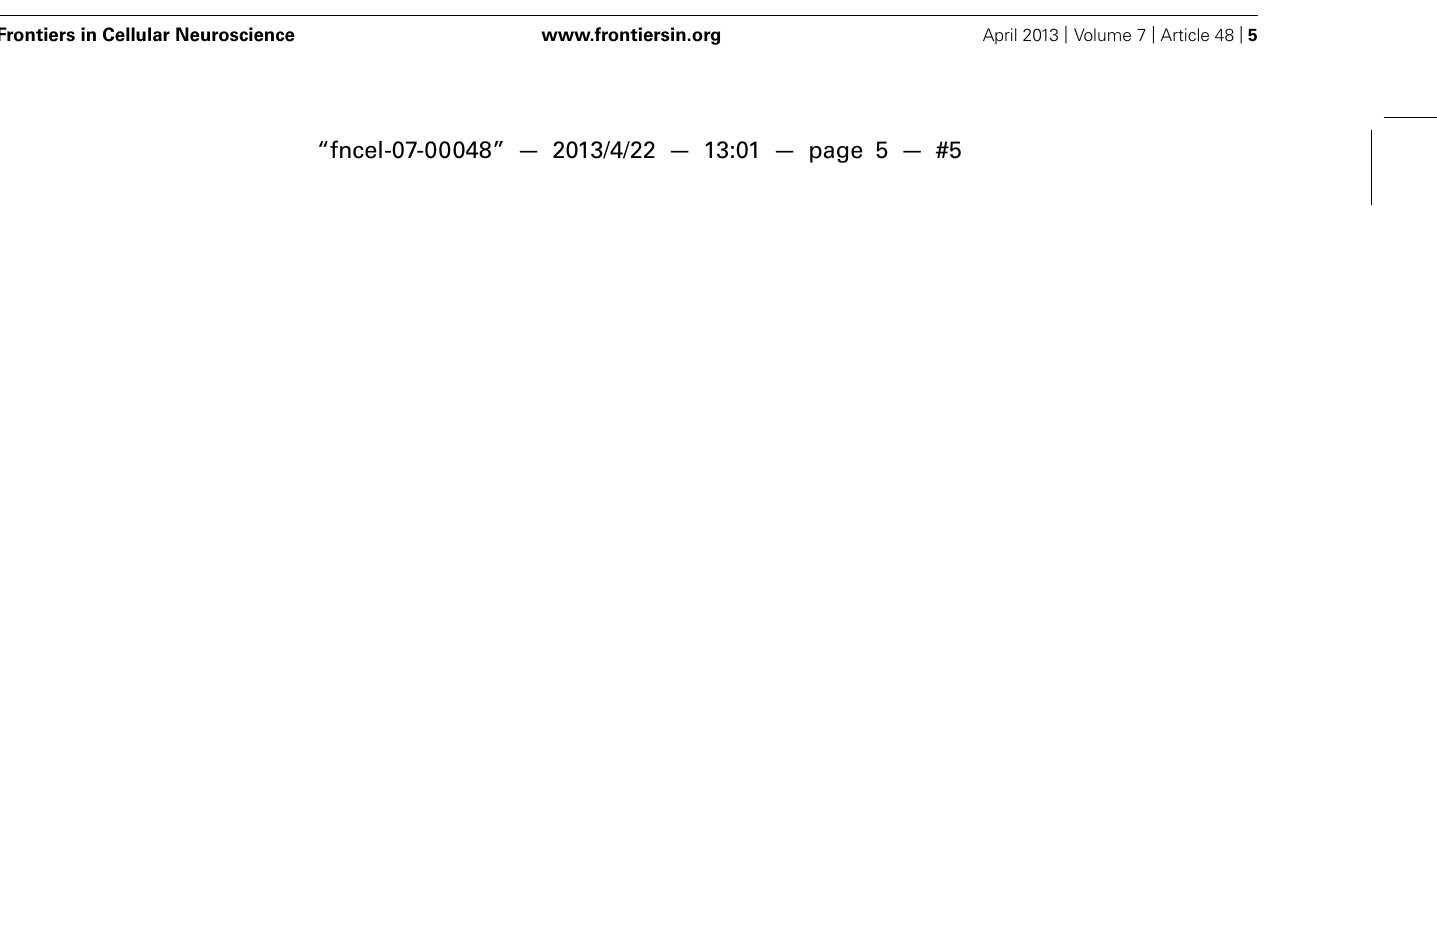
warm: − 44.9 ± 1.7 mV; AHP: cold: 15.0 ± 0.7 mV; warm: 16.6 ± 3.1 mV. P value for each data group > 0.05. N: cold-cut n = 5, warm-cut n = 5. R m , input resistance; AP, action potential; APHW, action potential half-width; I CMD , step command current; C m , estimated neuronal capacitance (see methods). For averaged AP shapes, the thickness of the trace signifies ± SEM. Note that for bar graphs in A (bottom right), values for APHW and I h -sag have been scaled (100 × and 10 × , respectively) for visual clarity. Also, note that in the left graph of the bottom panel, for correct comparison of current-to-firing relationships between neurons of possibly differing membrane resistances, the command current ( I CMD ) is scaled by multiplying by the measured R m for each cell. (B) . Morphology of a Purkinje neuron from a warm-cut slice (mouse age P18) filled with biocytin during electrophysiological recording. Compared to cold-cut, biocytin-filled Purkinje neurons (Jaeger, 2001; Bekkers and Häusser, 2007), there was no evidence suggesting that dissection temperature affects dendritic